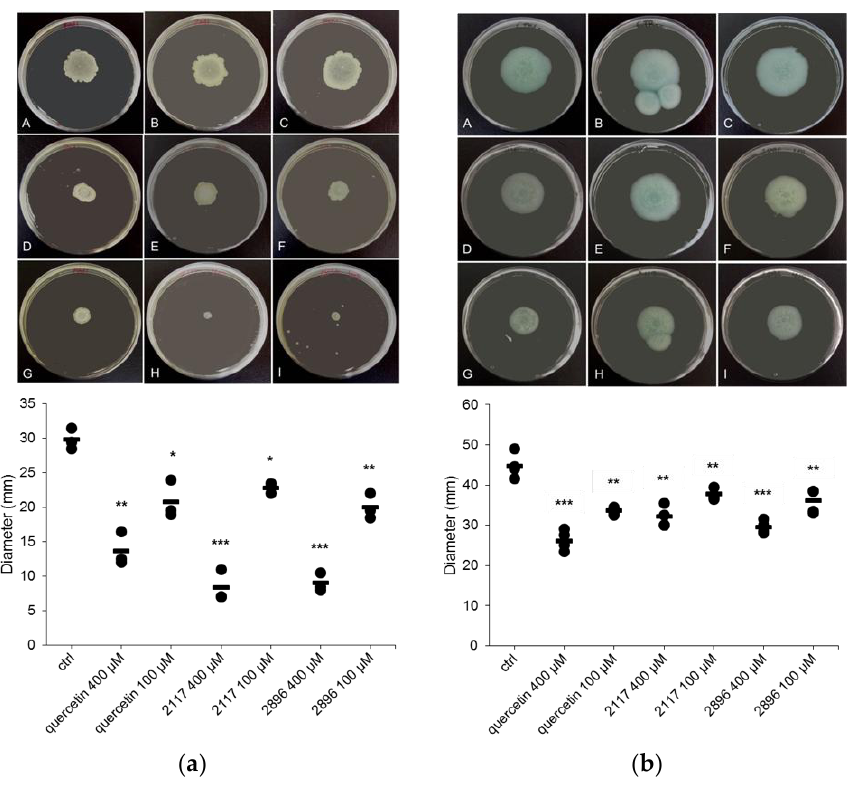
Figure 6. Inhibition of swarming ( a ) and swimming ( b ) motility of P. aeruginosa PAO1 by the lead compounds. In both panels, ( A – C ) untreated P. aeruginosa PAO1, ( D – F ) P. aeruginosa PAO1 treated with quercetin, 2117 and 2896 at 100 µM, and ( G – I ) P. aeruginosa PAO1 treated with quercetin, 2117 and 2896 at 400 µM, respectively. Results are shown as mean ± SD of three (swarming) and four (swimming) independent experiments. Statistical differences are marked in the Figure as: * p < 0.05; ** 0.001 < p < 0.05 and *** p < 0.001).